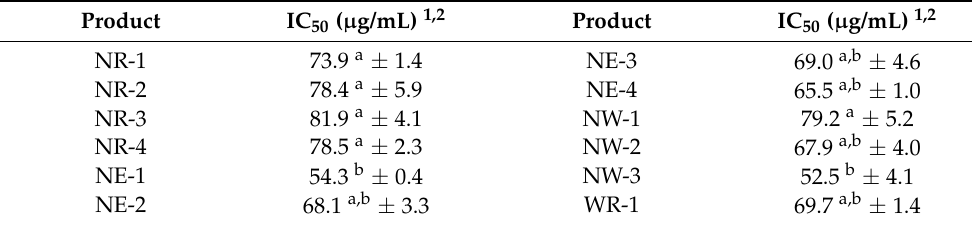
Table 6. NO scavenging activity of extracts from C. longa